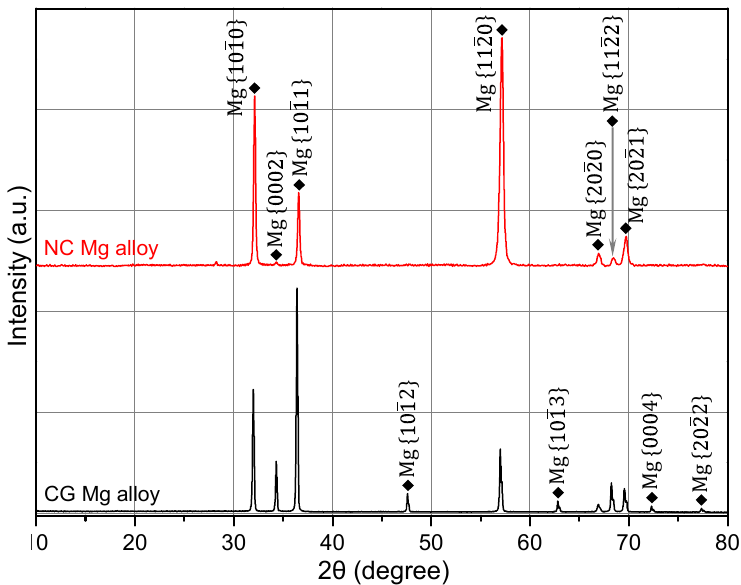
Figure 3. XRD patterns of the cross sections of nanocrystalline (NC) and coarse-grained (CG) Mg–Gd–Y–Zr alloys.